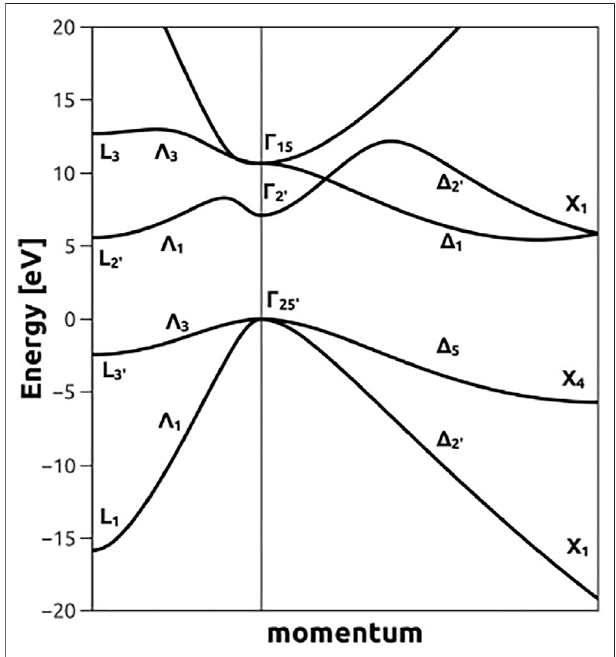
FIGURE 11 | Electronic energy bands of diamond along Δ and Λ symmetry lines